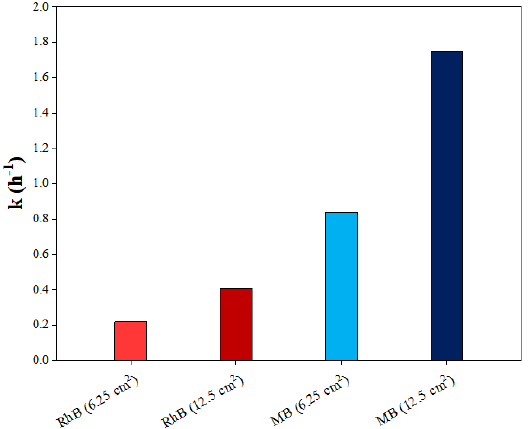
Figure 7. Effect of coated surface area on photocatalysis kinetics of RhB and MB.